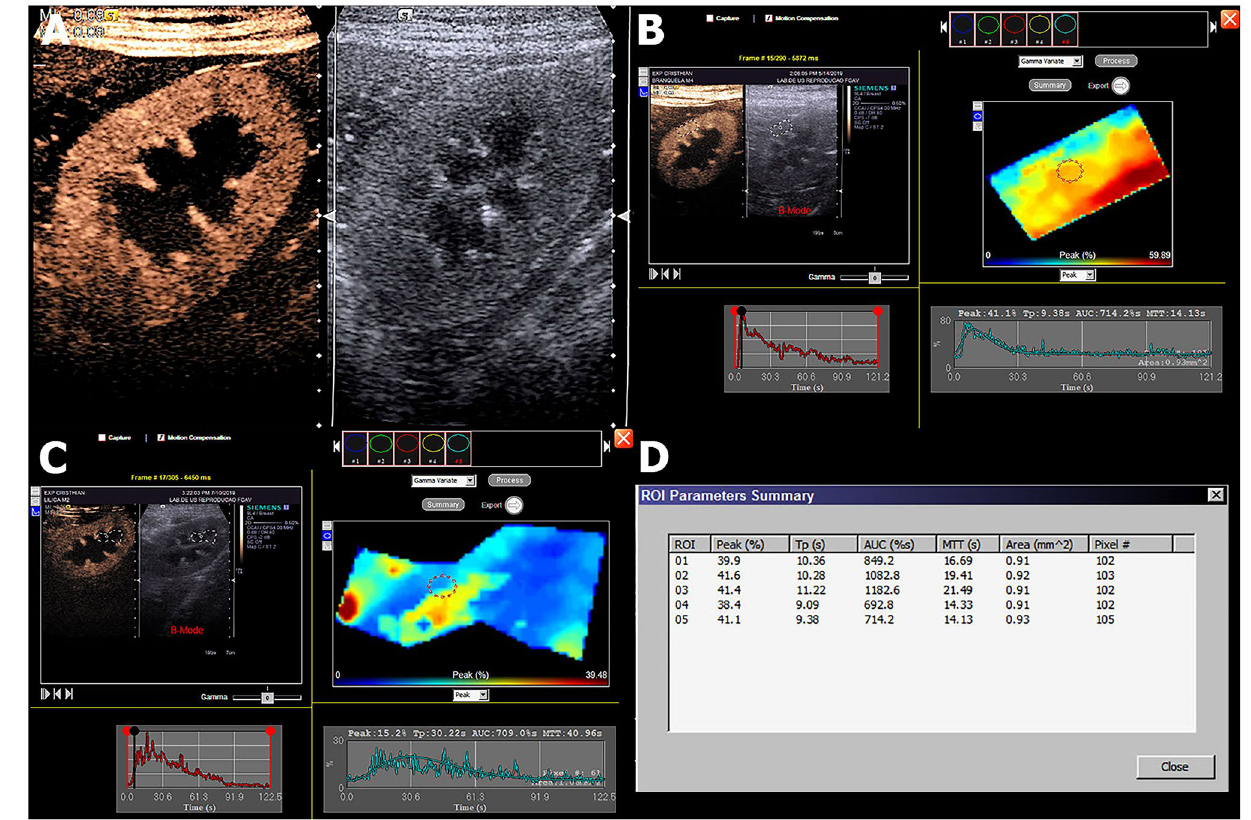
Figure 4. Contrast-enhanced ultrasound (CEUS) evaluations. ( A ) Qualitative CEUS evaluation of the left kidney, demonstrating the enhanced cortical aspect on the left compared to the B mode on the right on the peak of enhancement. ( B ) and ( C ) demonstrate the quantitative analysis of the cortical and medullar portions of the kidney, respectively, obtained by selecting an area of the region of interest (ROI), which is demonstrated in graphics. ( D ) Quantitative values obtained in the CEUS